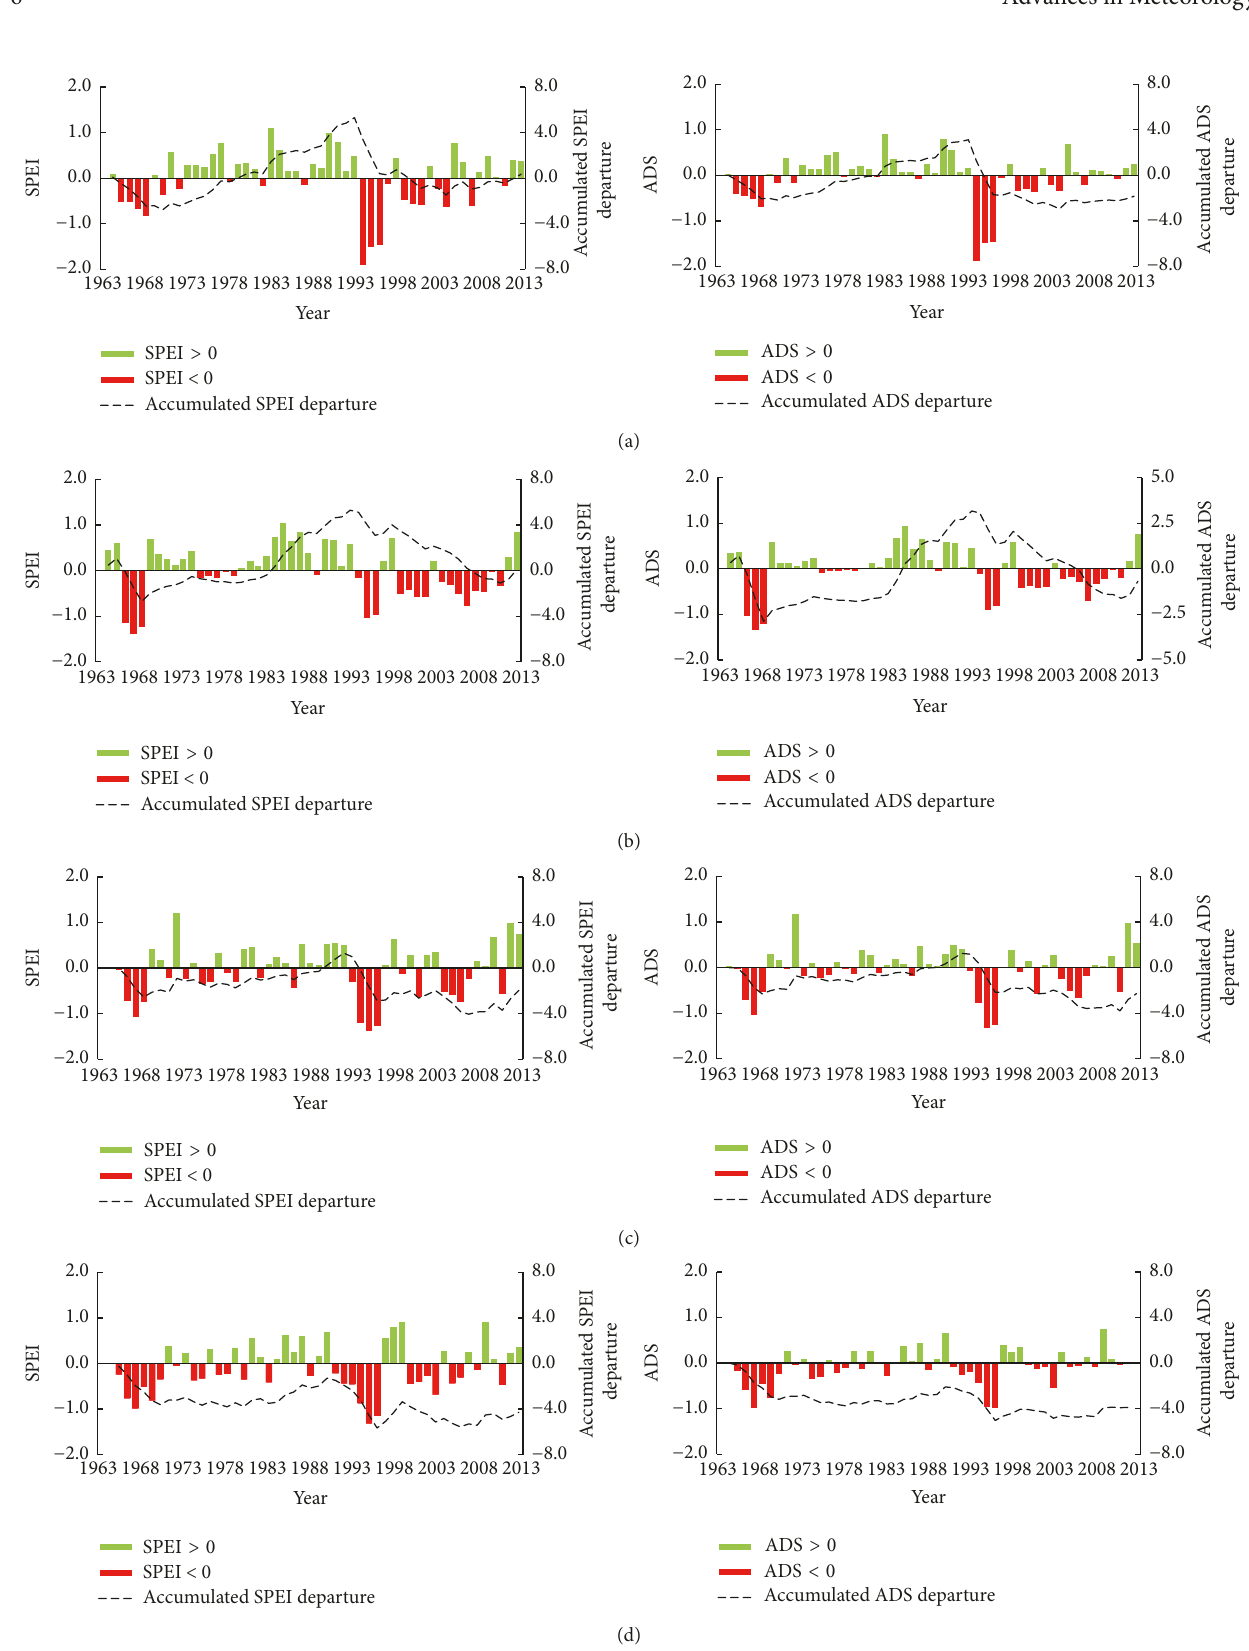
Figure 3: The interannual variability of (a) spring, (b) summer, (c) autumn, and (d) winter SPEI value (left) and ADS value